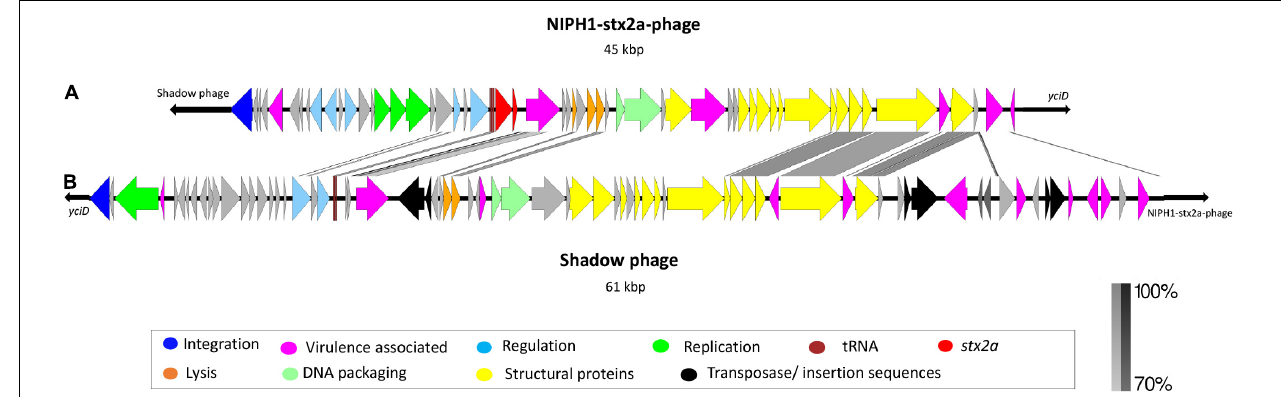
FIGURE 2 | Description and alignment of the two identified phages at integration site yciD in NIPH1 O145:H25 STEC. (A) The Stx2a phage (NIPH1-Stx2a-phage), size 45 kbp. (B) Remnants of a phage with the same genomic organization as the NIPH1-Stx2a-phage, but without the stx2a gene, referred to as shadow phage. It is 61 kbp long. The shadow phage is placed upstream of the NIPH1-Stx2a-phage in the integration site yciD . Several of the genes encoding structural proteins, tRNAs, and lysis genes show higher than 70% homology at nucleotide level between the two phages. However, the shadow phage harbors several different effector genes not present in the